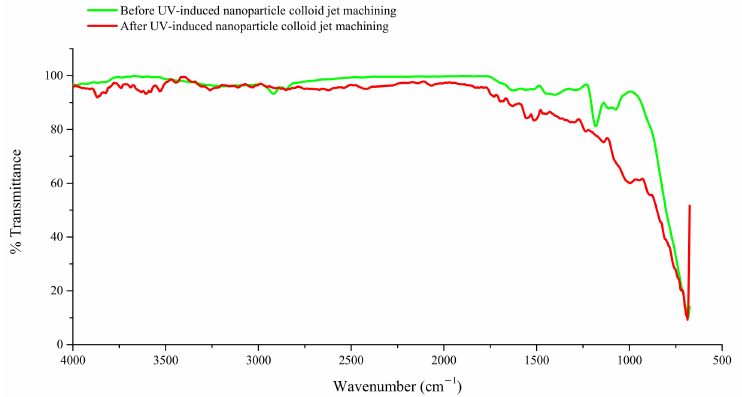
Figure 4. FT-IR of Ti i-6Al i-4V before and after UV-induced nanoparticle colloid jet machining.